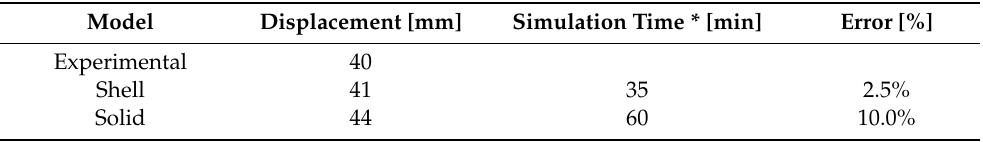
Table 2. Comparison of the maximum deflection of the ski in the three-point bending test: Finite element analysis (FEM) vs. experiments.